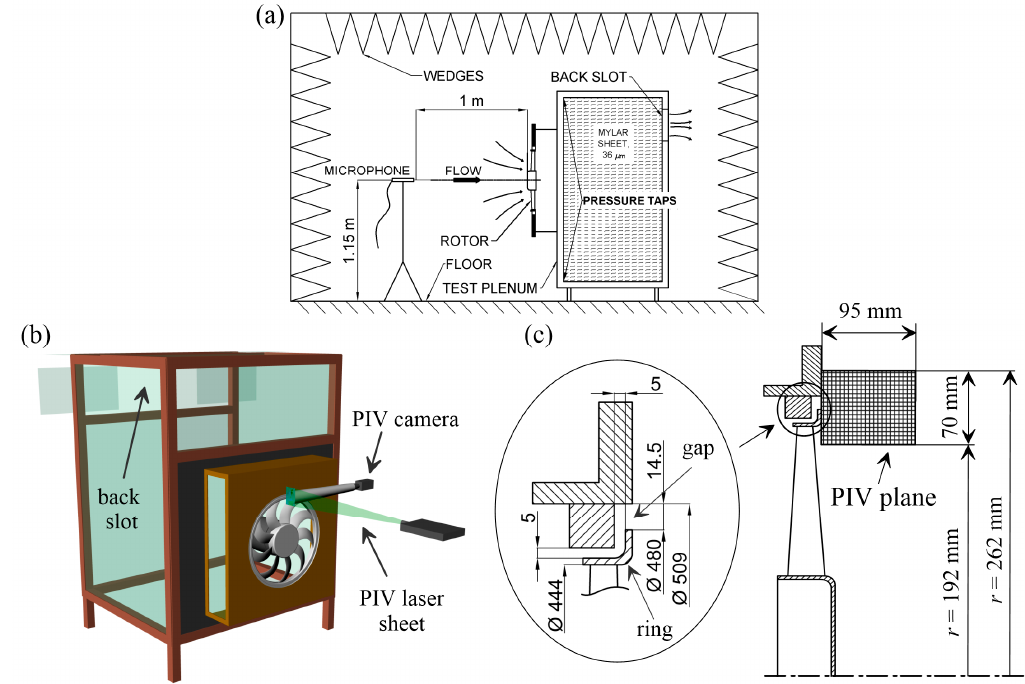
Figure 2. Experimental facility. ( a ) Hemi-anechoic chamber and acoustic setup; ( b ) Test plenum and aerodynamic setup; ( c ) Particle image velocimetry (PIV) measurement domain and gap geometry (not to scale).